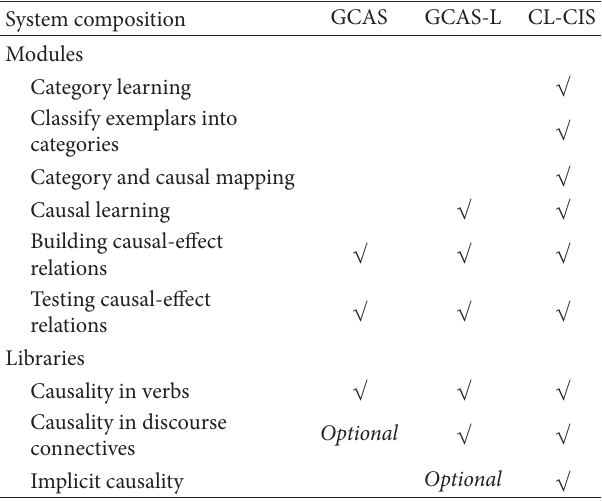
Symbols in Figure 4 are defined in Table 5: the first order weight matrices W RI and W OR fully connect the units of the input layer (IL), the recurrent layer (RL), and the output layer (OL), respectively, as in the feed forward multilayer perceptron (MLP). The current activities of recurrent units RU (𝑡) are fed back through time delay connections to the context layer, which is presented as CU (𝑡+1) = RU (𝑡)